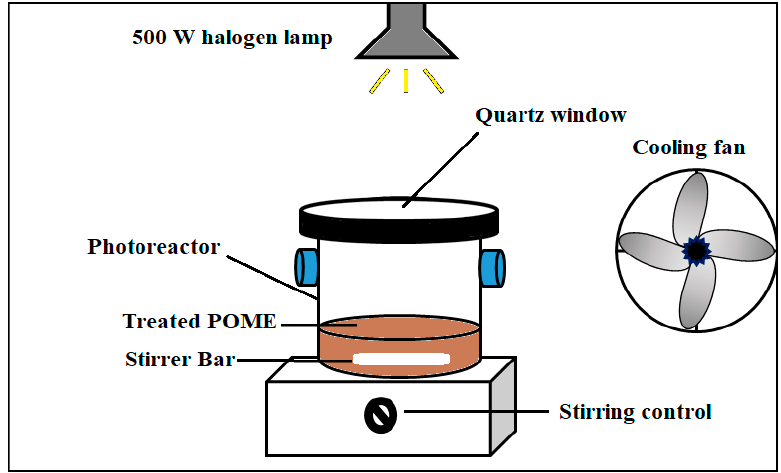
Figure 1. Schematic sketch of the experimental setup for photocatalytic